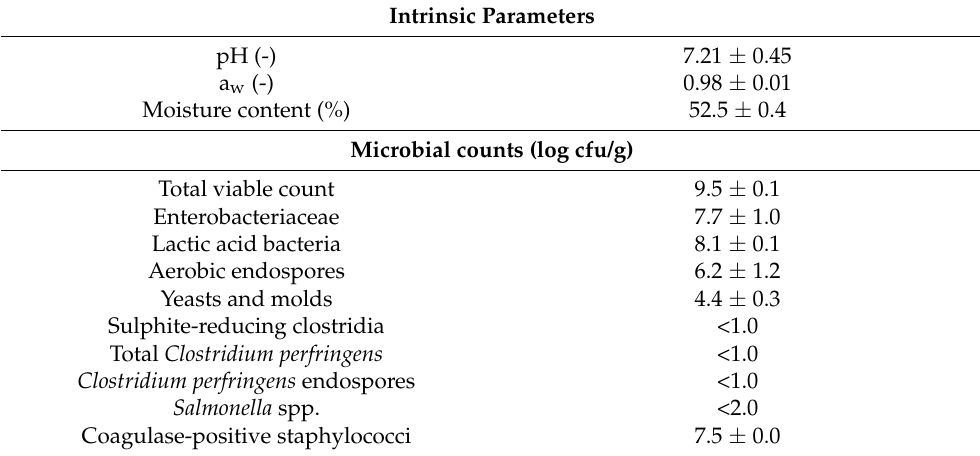
Table 2. Intrinsic parameters and microbial counts of untreated frass of black soldier fly larvae. Results are presented as the mean of three replicates ± standard